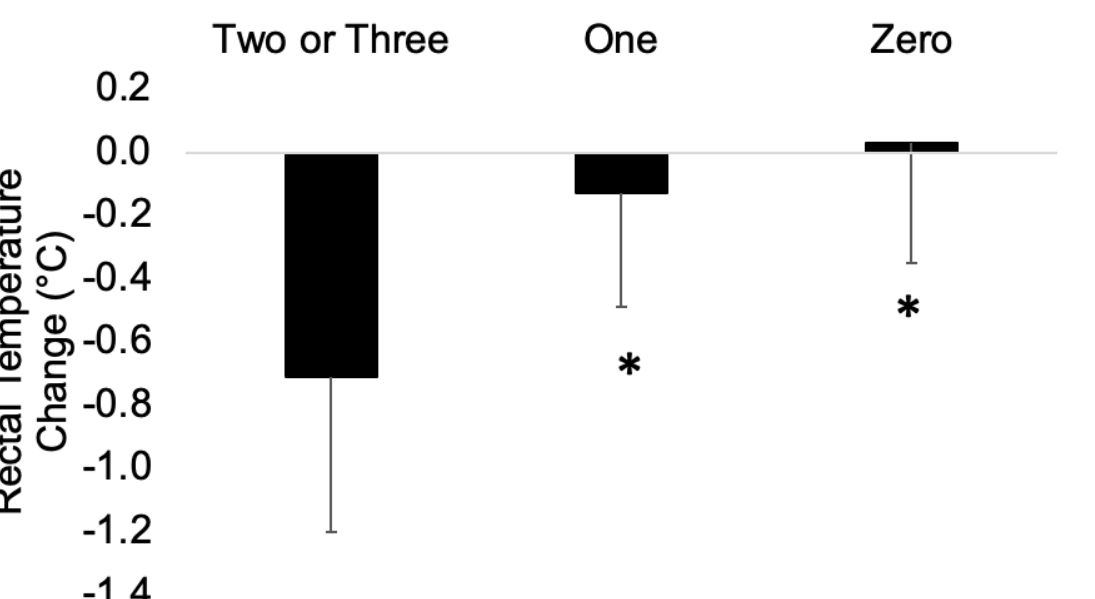
Figure 3. The differences in rectal temperature between pre- and post-test when two or three varia- bles, one, and zero variables met the cut-points. * indicates statistical significance from when two or three variables met the cut-points, p ≤ 0 .05.